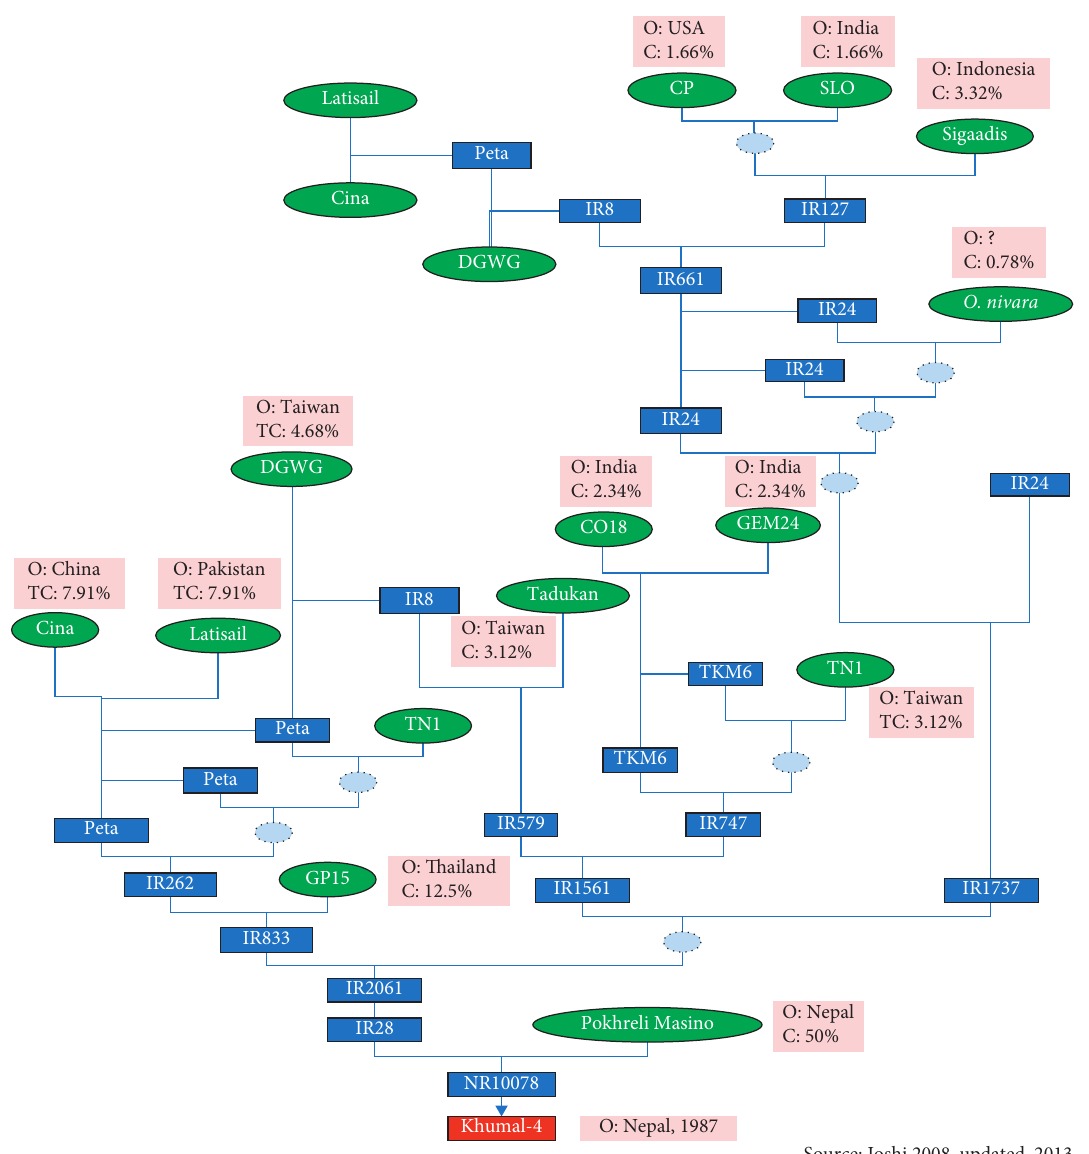
Figure 3: Complete pedigree tree of Khumal-4 rice variety